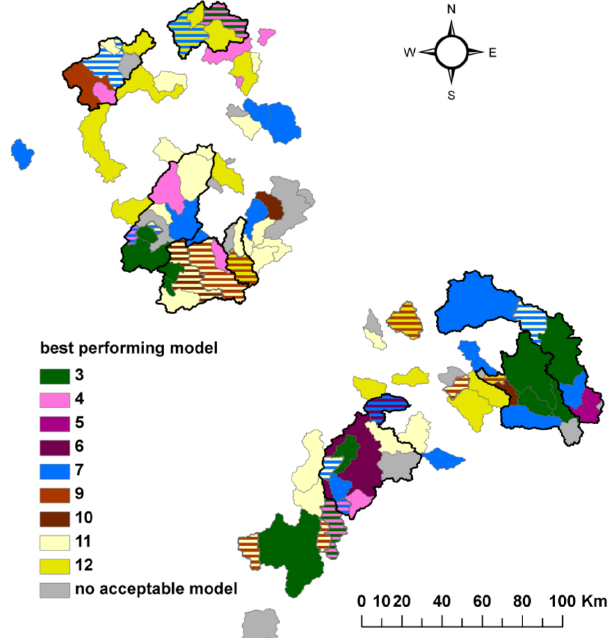
Figure 8. Spatial distribution of catchments with equal best performing models. Catchments with two best performing models are striped in the color of both model structures. Please note that nested catchments are sorted by size: only the headwater catchments are displayed completely. Borders of large catchments with several upstream catchments are marked with a bold line.